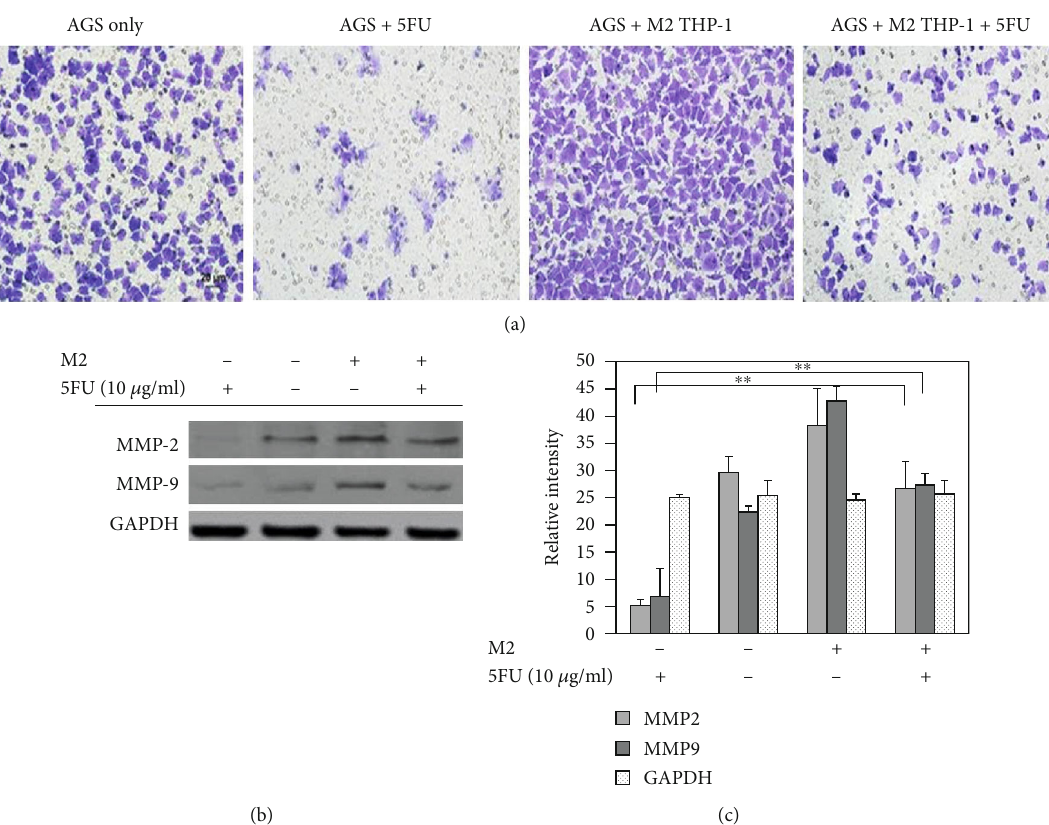
Figure 4: Cell migration and invasion of AGS cells. (a) AGS cells were plated in 0.8 μ m pore size Transwell and incubated for 24h. After 24h incubation, AGS cells were treated with 10 μ g/ml of 5FU in FBS free media, and the inserts were added in wells containing polarized THP-1- M2 macrophages or fresh media and incubated for further 24 h. After 24h, nonmigrating cells on the upper side of the membrane were removed and migrated cells on the lower side of the membrane were fi xed with ice-cold methanol. Fixed membranes were stained with 0.5% crystal violet. (b) Western blot analysis of MMP-2 and MMP-9 proteins. (c) Quanti fi cation of western blot bands. Statistically signi fi cant di ff erence was set at ∗∗ P < 0 : 01